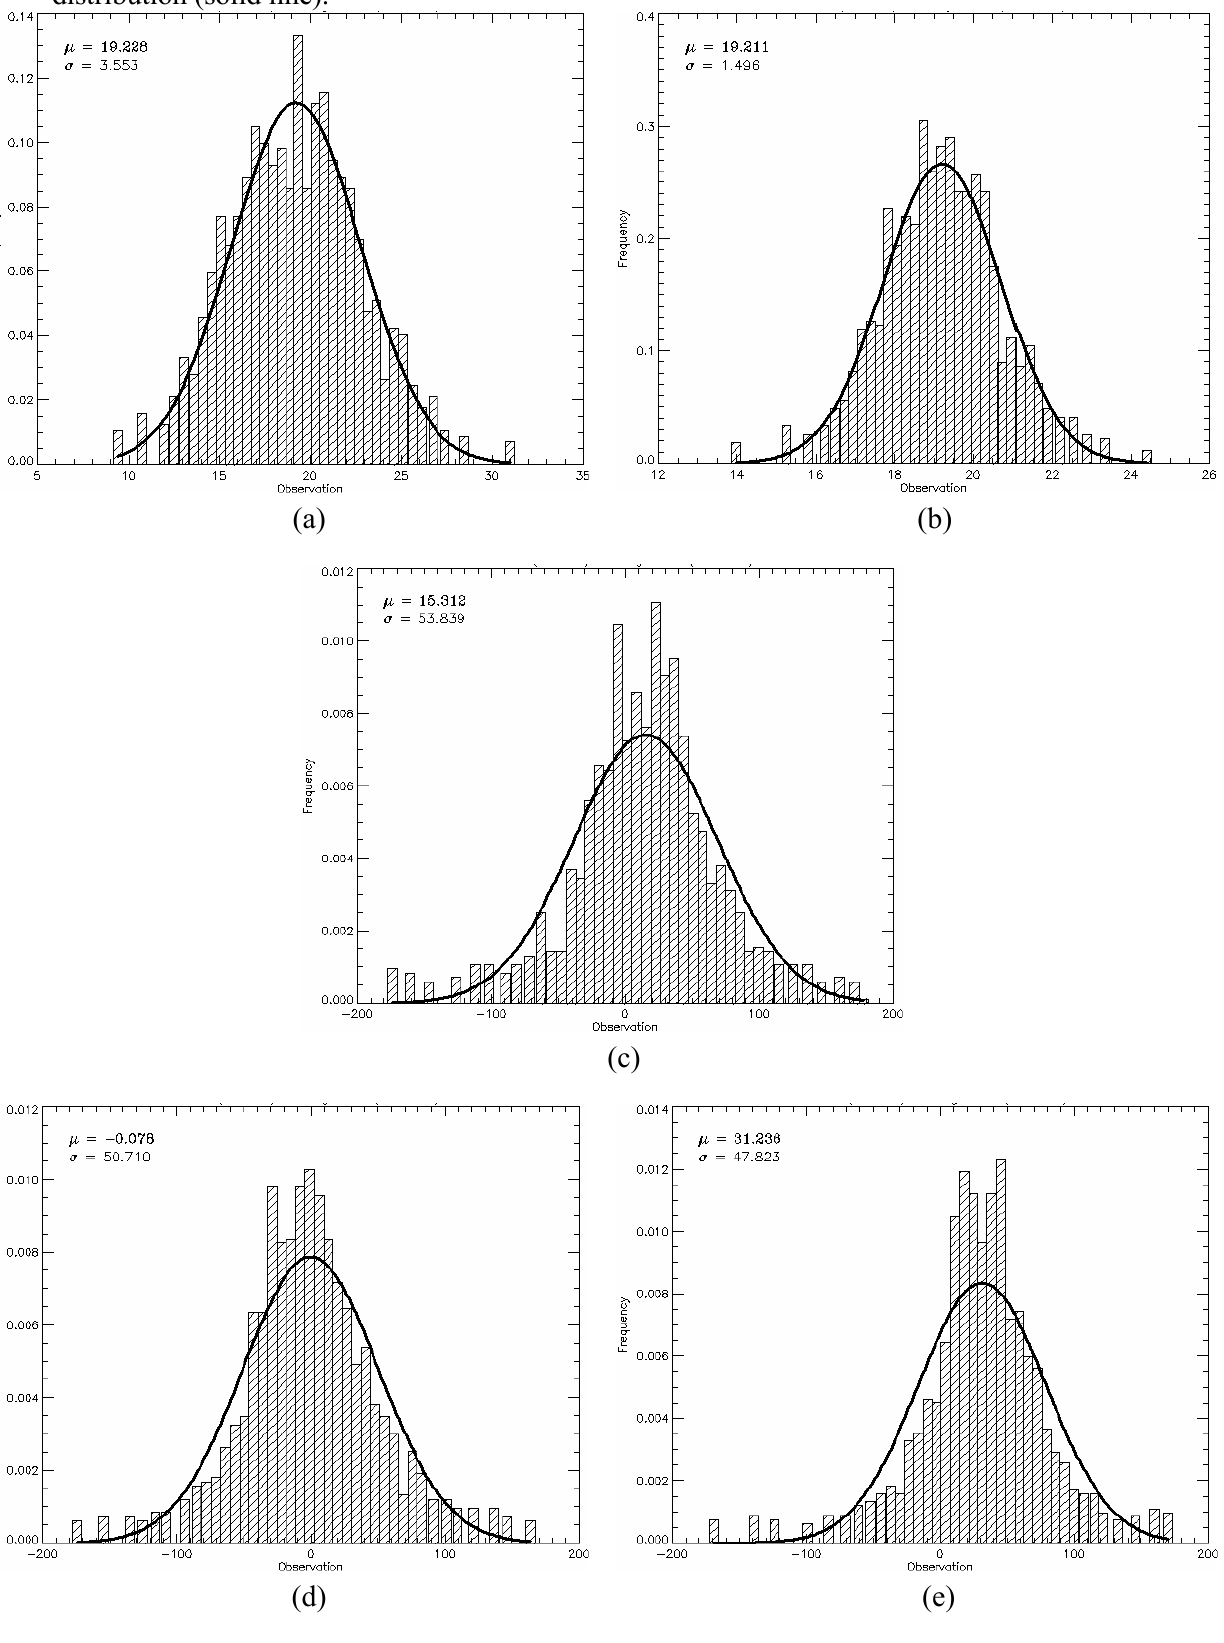
Figure 18. L-band PPD ’s histogram for all regions in comparison to theoretical Gaussian distribution (solid